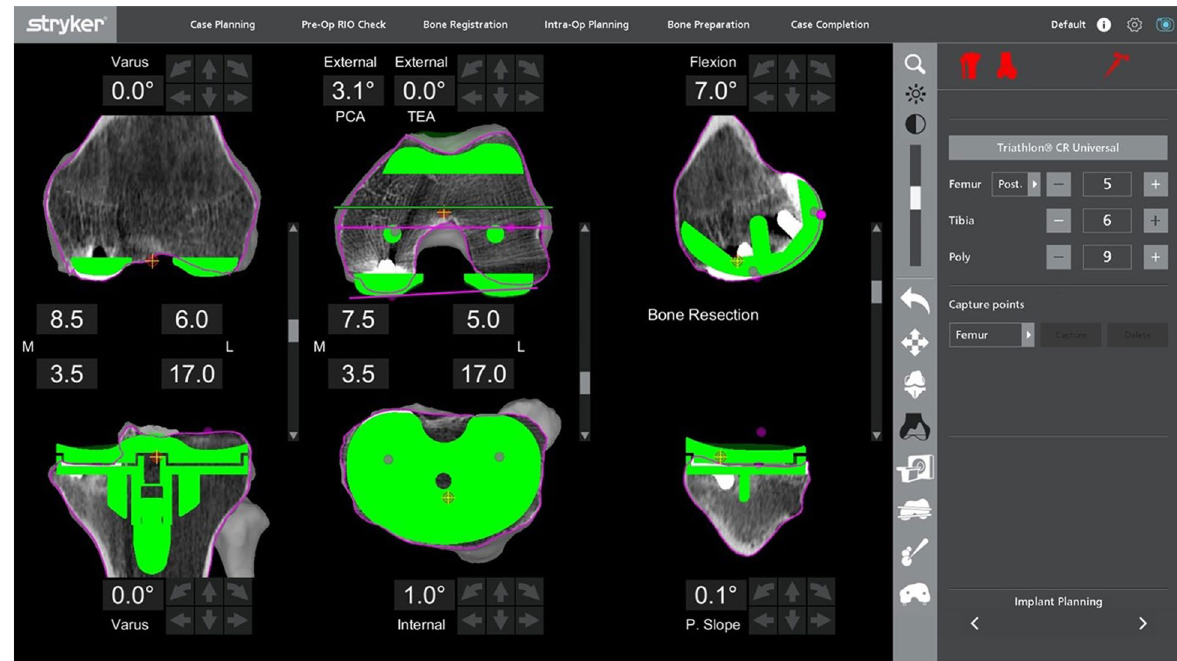
Fig. 9 Preoperative planning of a patient with existing UKA revised to a TKA (a mechanically‑aligned knee